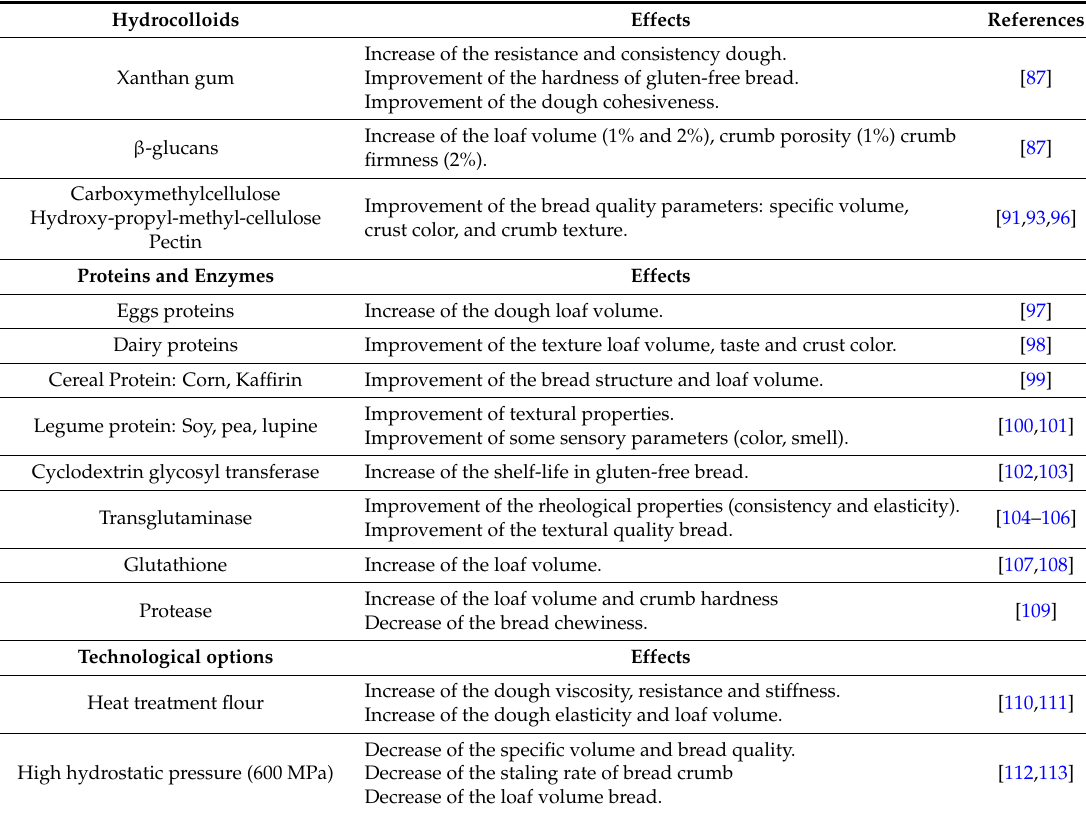
Table 2. Main ingredients and technological options used in the bread-making.